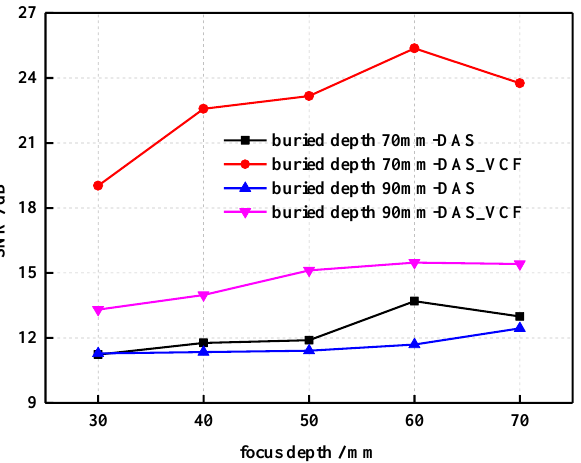
Figure 9. Comparison of SNR curve for defects with a buried depth of 70 mm and 90